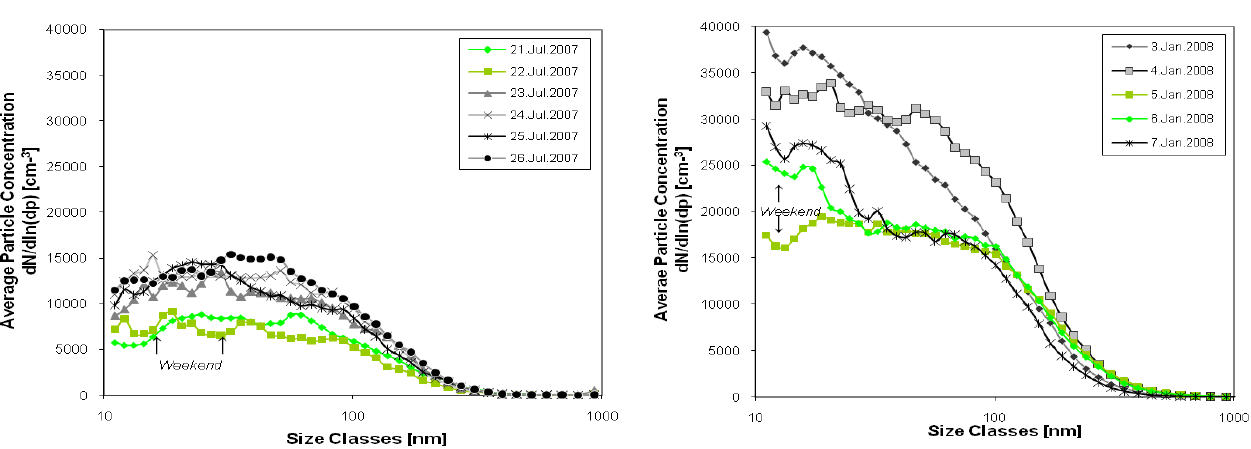
Figure 1. Daily average UFP size distribution at the downtown site (Salzburg— Rudolfsplatz). Left panel: summer measurement, right panel: winter measurement. Significant drop in UFP on weekends is